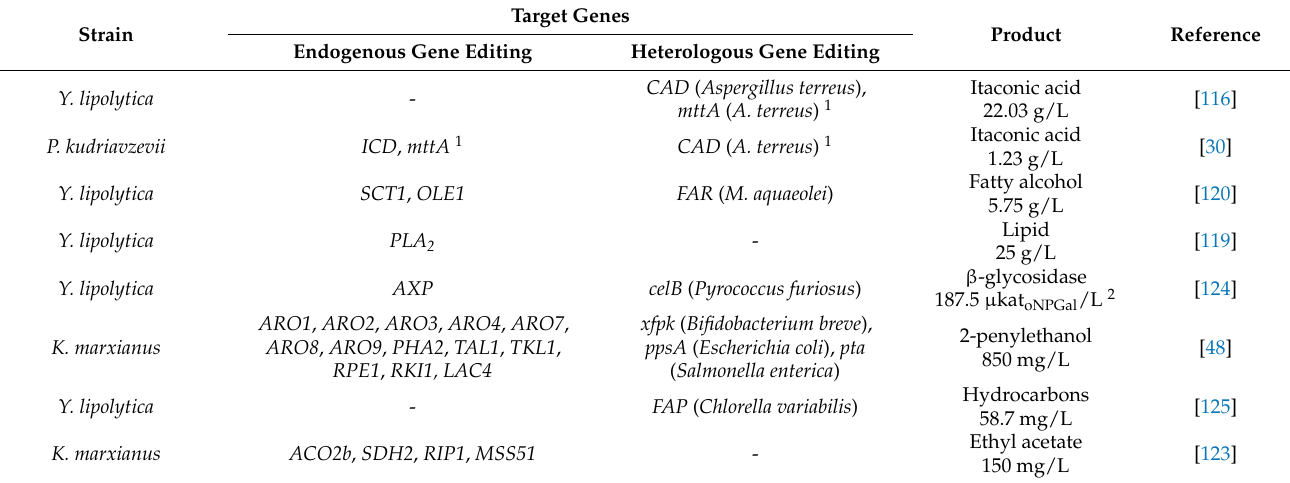
Table 3. Production of industrially useful products using CRISPR-Cas9 in